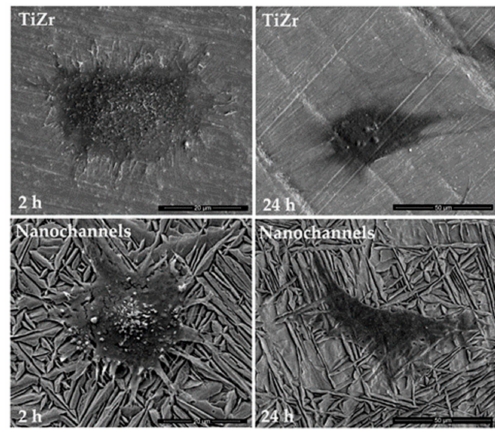
Figure 3. SEM images of MC3T3-E1 cells attached on the nanochannelar and flat TiZr surfaces imaged at 24 h post-seeding.